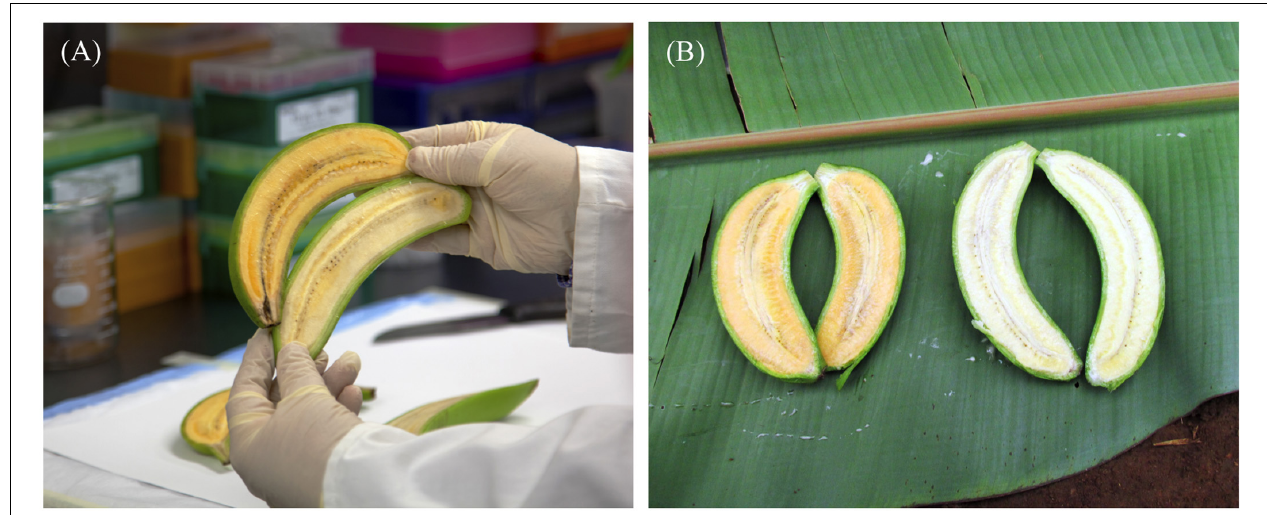
FIGURE 2 | (A) PVA-biofortified “Cavendish” banana in Australia and (B) PVA-biofortified (left) and wild-type control (right) “Nakitembe” EAHB in Uganda.